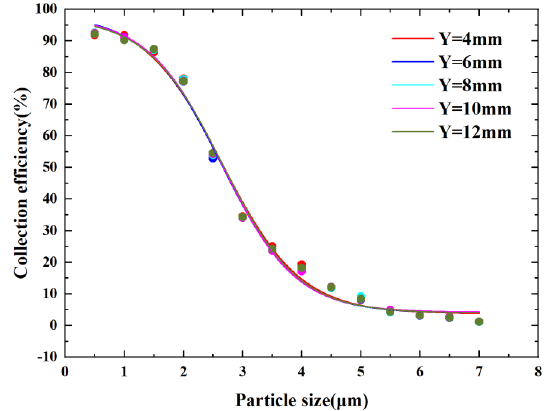
Figure 8. CE curves at different Y values.